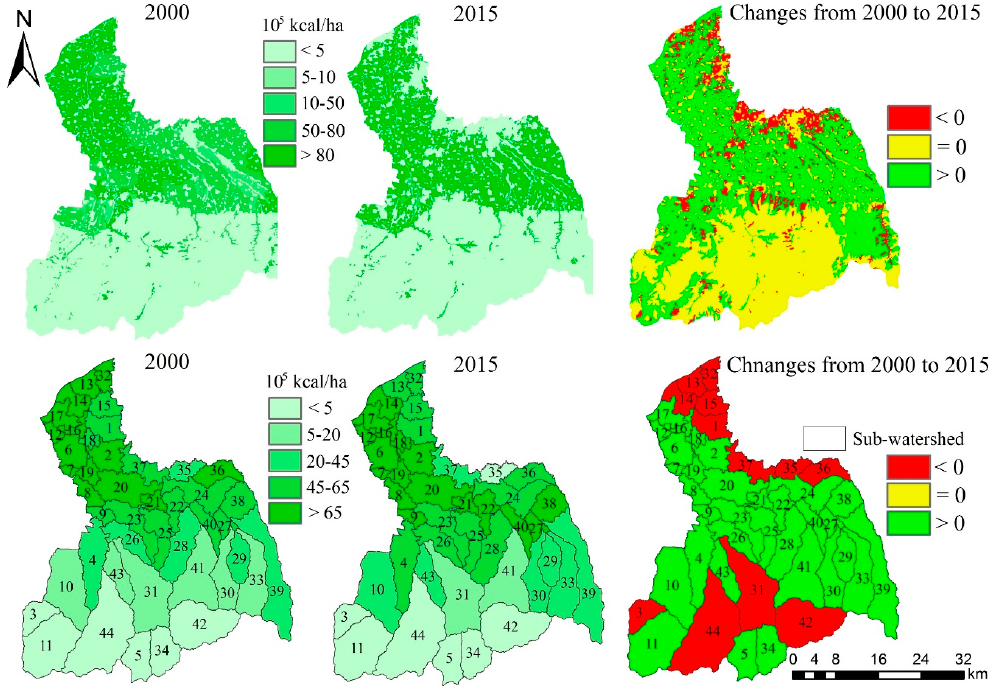
Table 2. The classification of supply–demand risks of ES.